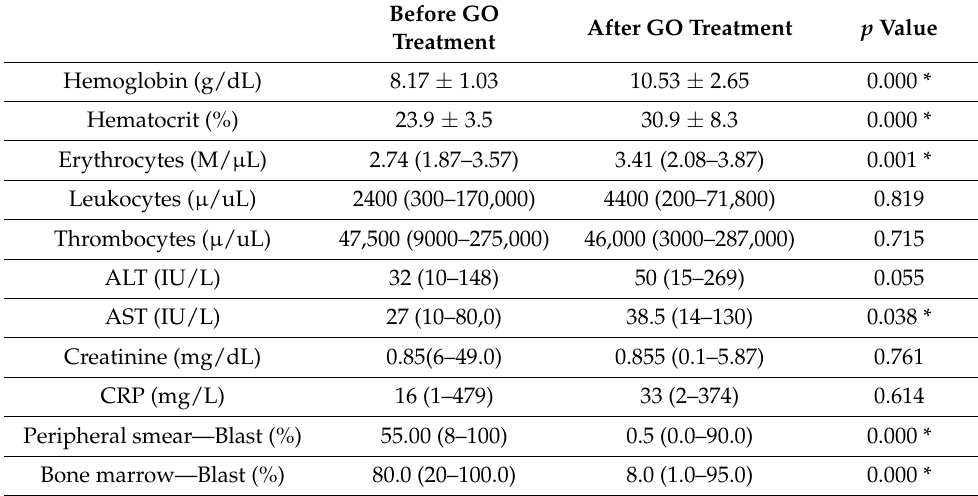
Table 3. Significance values for biochemical parameters before and after treatment with